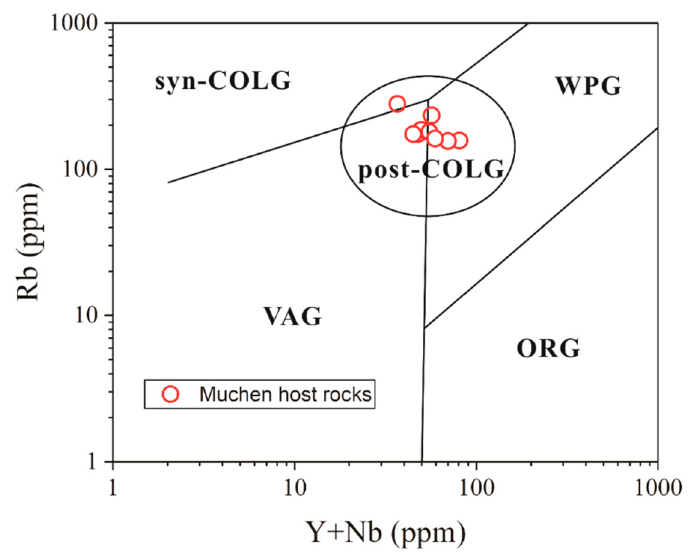
Figure 18. Tectonic discrimination diagrams for the Muchen alkaline rocks [123]. The field for post-collision granite (post-COLG) from Pearce [120]. Abbreviations: syn-COLG: syn-collision granite; post COLG: post-collision granite; WPG: within-plate granite; ORG: ocean ridge granite; VAG: volcanic arc granite.